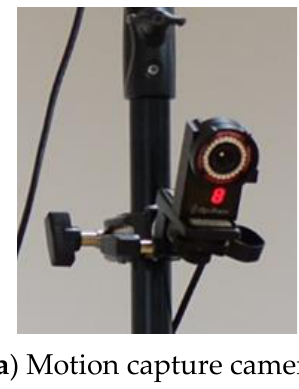
Figure 5. Experimental equipment.